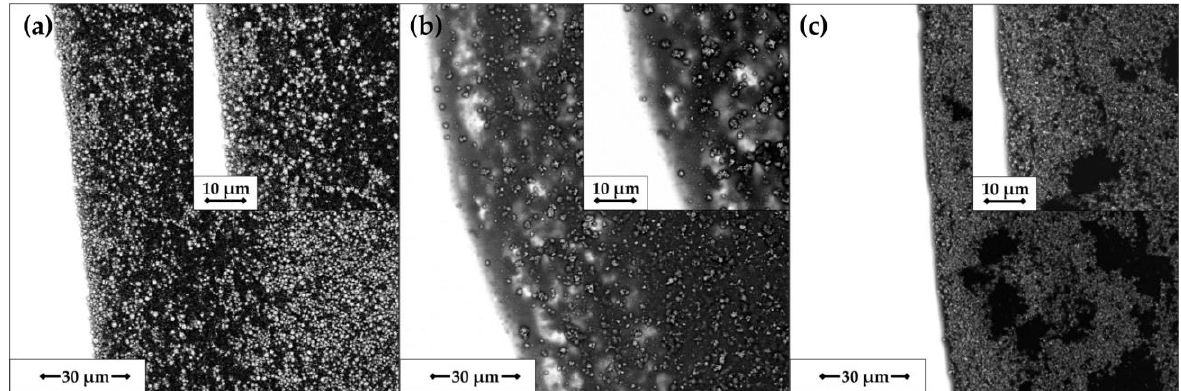
Figure 4. SEM images of dry deposits: ( a ) CH_0.5/25%; ( b ) NAF_0.5; ( c ) PVP_1.0/25%.